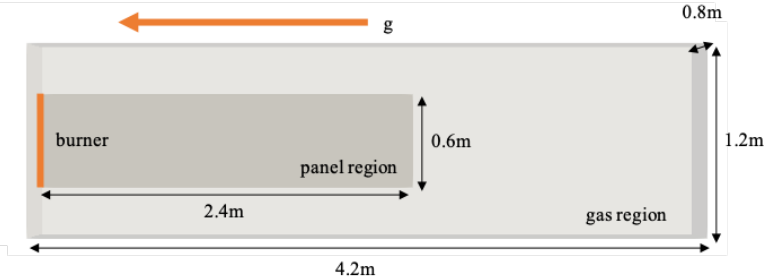
Figure 1. Schematic of the vertical fire spread case, showing the propane burner in orange, as well as both the panel and gas regions. The orange arrow indicates the direction of